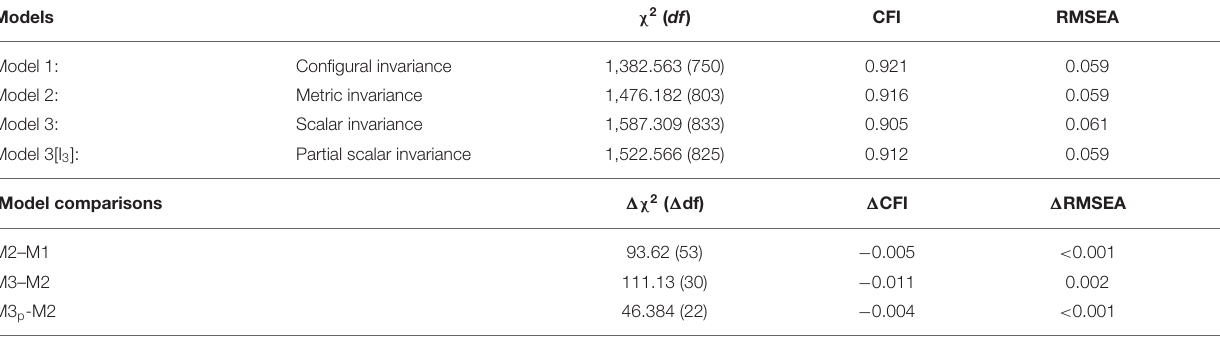
TABLE 4 | Measurement invariance across gender on impostor-profile with 30 items (IPP30).